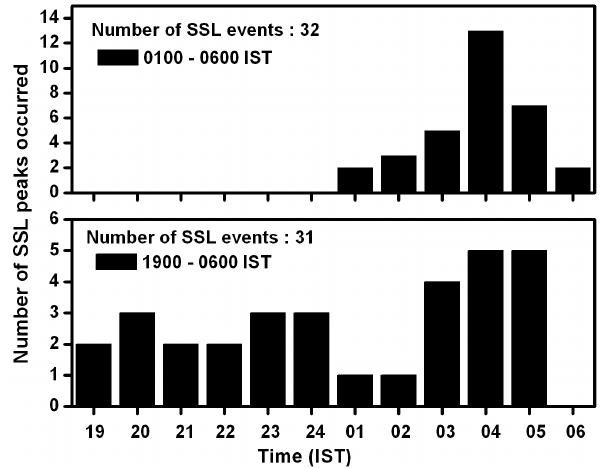
Fig. 6. Trajectories of the height of sporadic peaks.